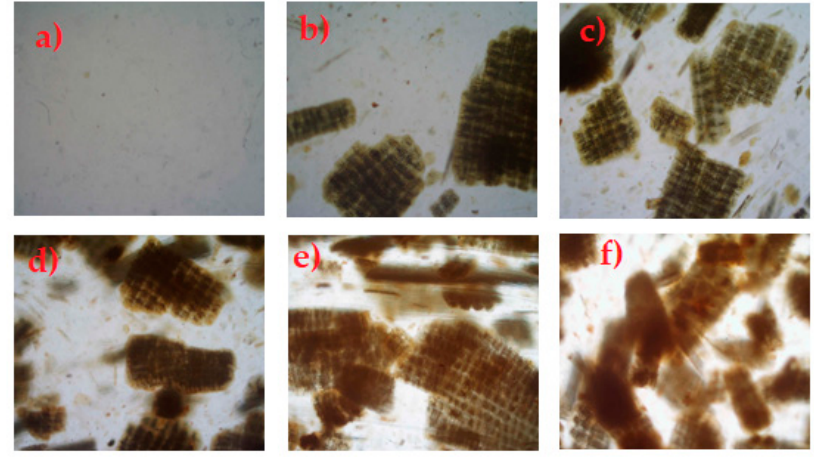
Figure 2. Optical micrographs of ( a ) neat LDPE, ( b ) LDPE + 10 wt % RH, ( c ) LDPE + 20 wt % RH, ( d ) LDPE + 30 wt % RH, ( e ) LDPE + 40 wt % RH and ( f ) LDPE + 50 wt % RH.